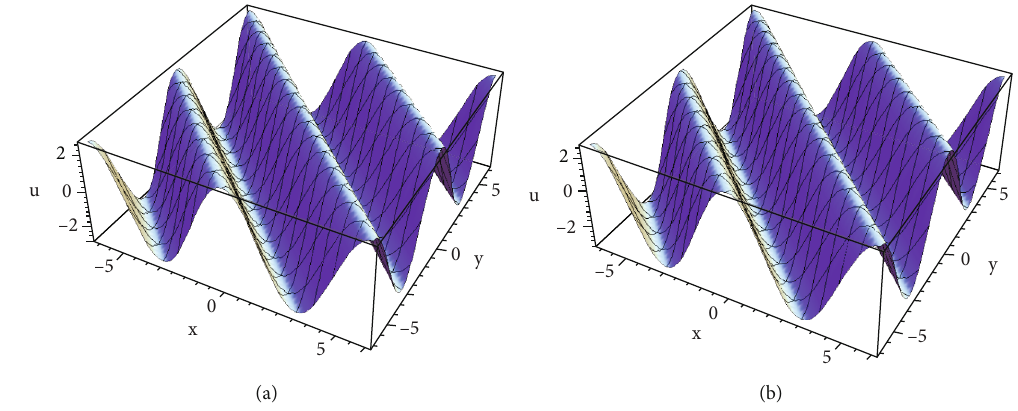
Figure 5: The outline of the periodic soliton. (a) for Eq. (45) and (b) for Eq. (51).